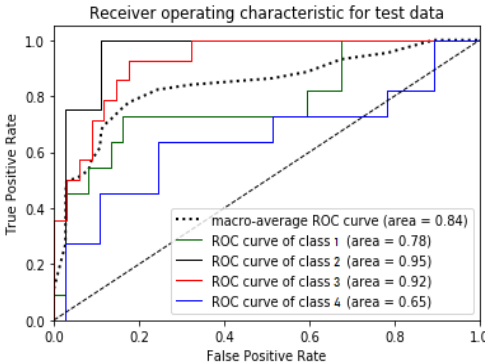
Figure 10. Haiti—ROC curves for each class of test dataset. Haiti’s classifier has performed well in classifying the sample data for each class except class 3, as all the curves are above the threshold. There are few false-positive appearing for class 3.